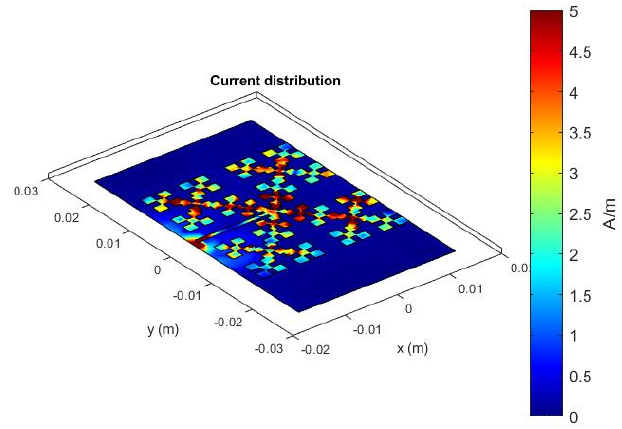
Figure 9. Fractal island lateral antenna at 182 GHz.